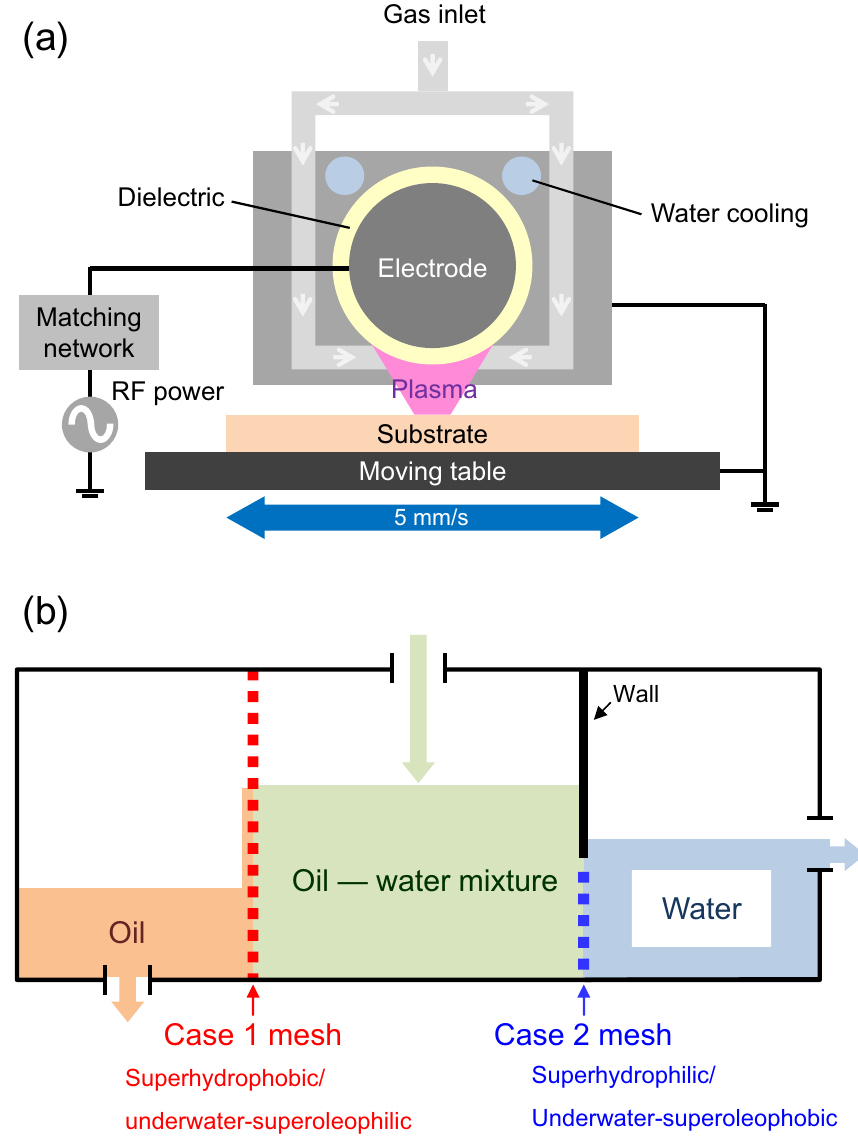
Figure 6. Schematic illustration of ( a ) the cross-sectional view of the atmospheric-pressure plasma source and ( b ) configuration of the oil–water separation